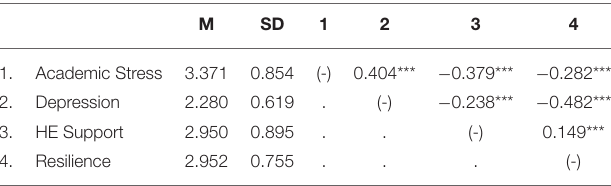
TABLE 2 | Descriptive statistics and Pearson’s correlation for all students on academic stress, depression, resilience, and HE support measures ( N =